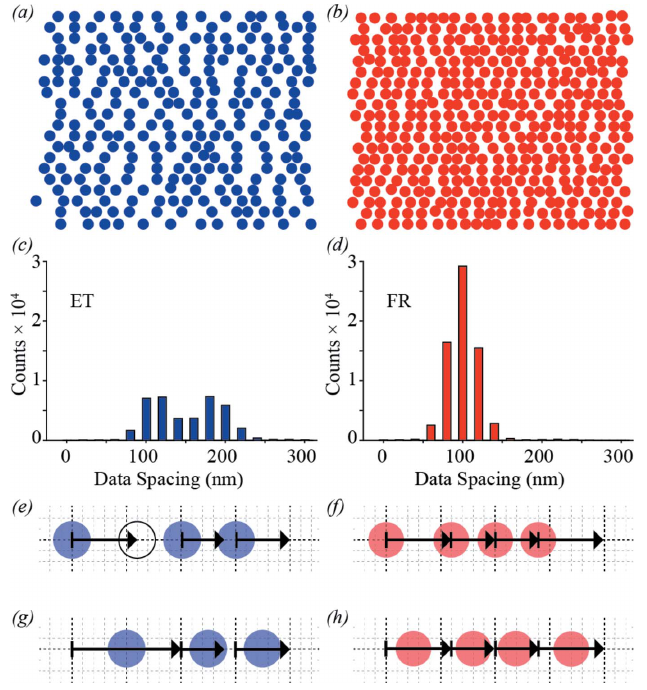
Figure 2 Comparison of fly-scanning SXDM positions in ( a ) externally triggered (ET) mode and ( b ) free-run (FR) mode, over a 2 m m (cid:3) 2 m m scan subregion of a 50 m m (cid:3) 50 m m scan. ( c ) The histogram of ET point spacing for the full scan is bimodal, while ( d ) the FR point-spacing histogram for the full scan is unimodal, see main text for discussion. ( e ) An illustration of the ET position assignment, where the heavy dashed vertical lines represent the pixel boundaries where triggers are sent to the detector, and the exposure time for each frame is indicated by the length of the arrow from the bar to the end of the arrowhead. The empty circle shows a missed frame when the trigger is issued during an exposure. ( f ) An illustration of the FR position assignment, where the light dashed lines represent the 20 nm encoder counts. ( g ) Interpolation of the positions in ET mode results in inaccurate estimation of the centre of the frames preceding a missed frame, while ( h ) in FR mode, the centres of all frames are accurately estimated. Note that the probe size is many times larger than the distance between stage